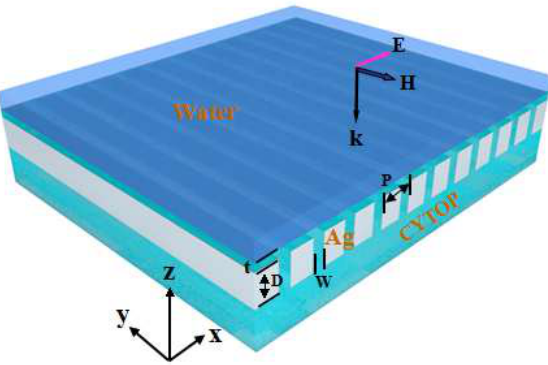
Fig. 1. Schematic of a metallic nanoslit arrays embedded in the CYTOP, with the geometrical parameters ( t , D , W and P ), and the direction of the TM-polarized incident